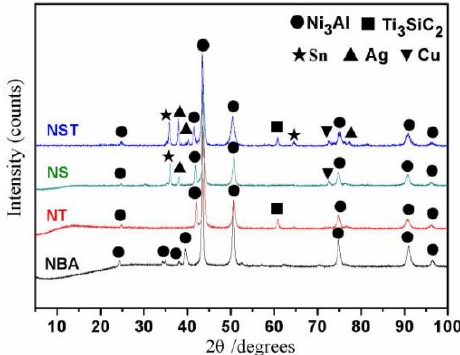
Figure 3. XRD pa tt erns of NBA, NS, NT and NST. Figure 3. XRD patterns of NBA, NS, NT and